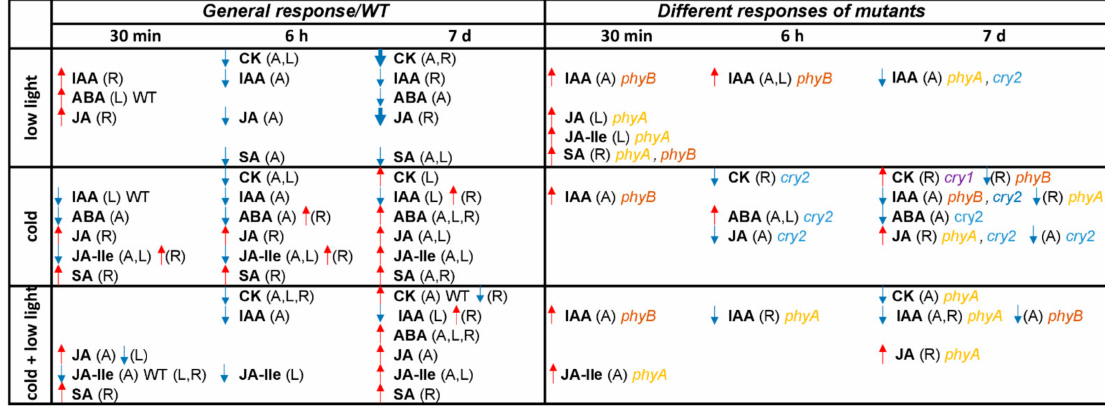
Figure 5. Scheme of significant changes in phytohormone contents. Upregulated (red arrows) or downregulated (blue arrows) hormone levels in shoot apices (A), leaves (L) and roots (R) under low light, cold at an optimal light intensity and combined cold and low light at different time points compared to control conditions. Left column contains either general response of all genotypes or WT (when specified). In the right column, responses of individual mutants distinct from the WT ones under the same stress conditions are shown. Thicker arrows indicate strong responses. ABA, abscisic acid; CK, cytokinin bases; IAA, indole-3-acetic acid; JA, jasmonic acid; JA-Ile, jasmonoyl-isoleucine; SA, salicylic